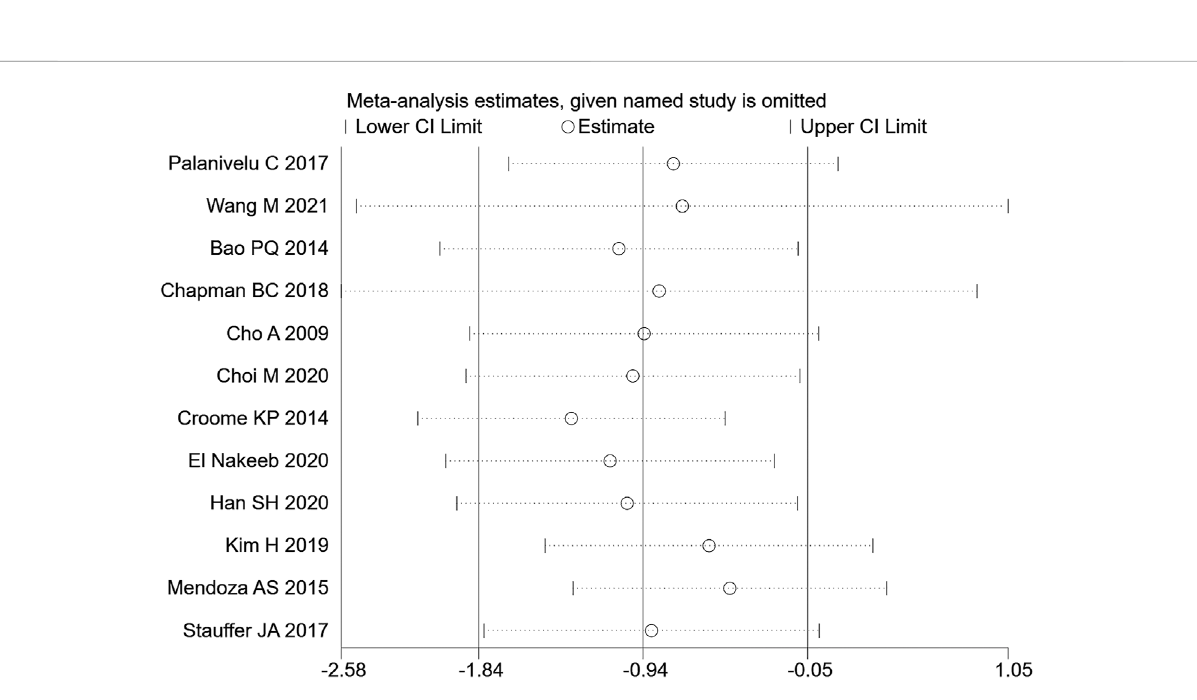
FIGURE 7 Sensitivity analysis of hospitalization